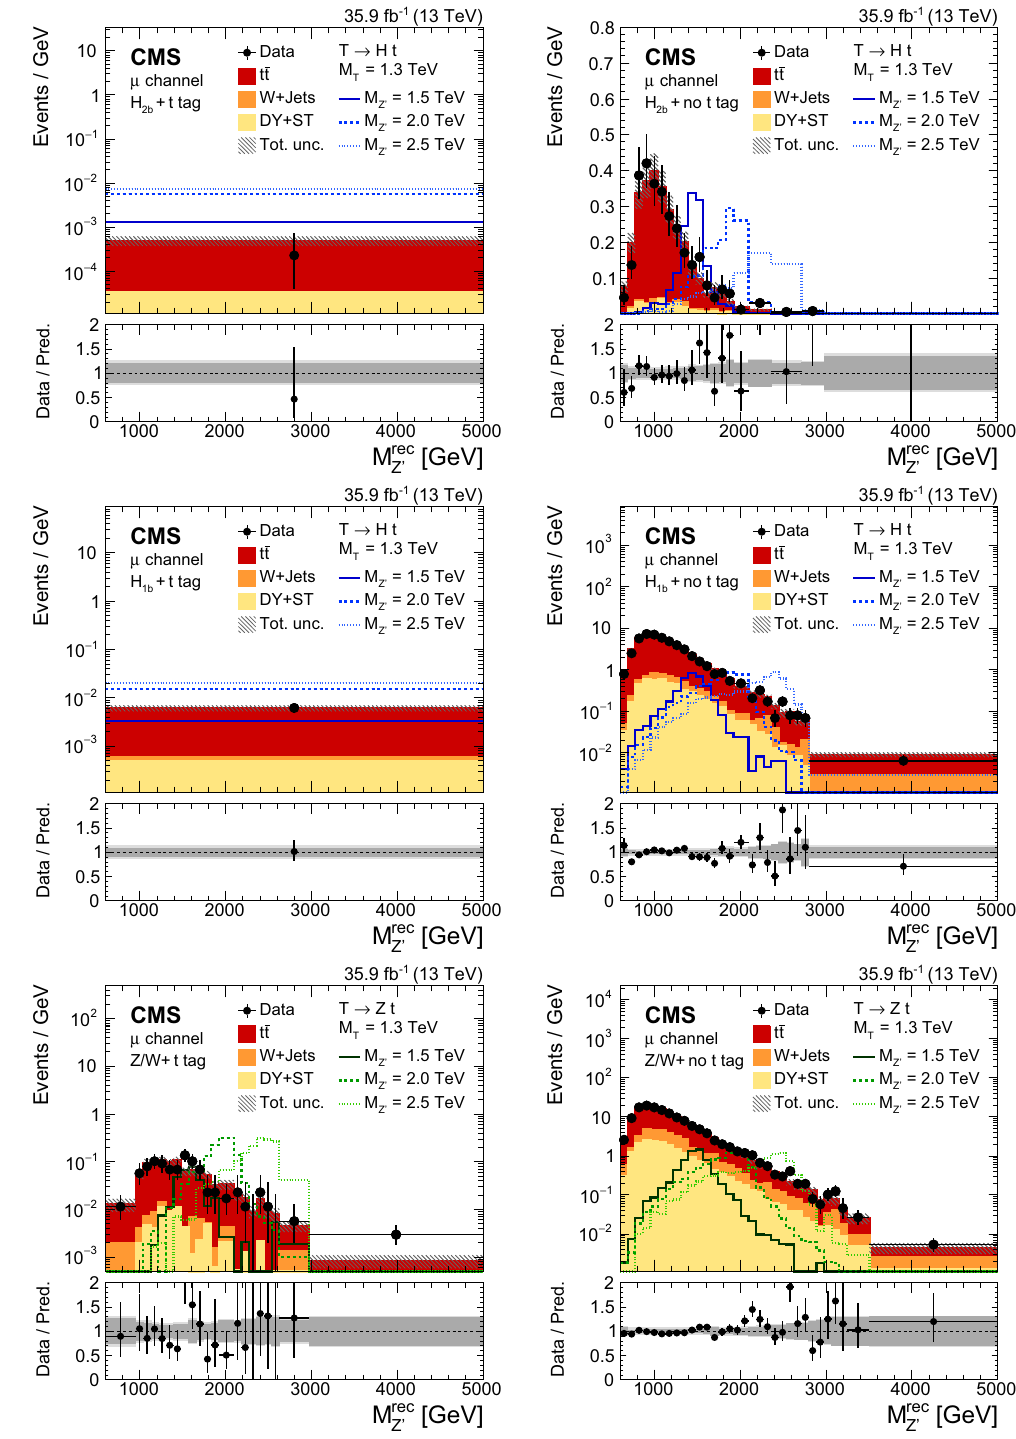
Fig. 5 Distribution of the reconstructed Z (cid:3) resonance mass after the full selection in the μ +jets channel for the data, the expected SM back- ground, and for the signal with different Z (cid:3) masses for a fixed T mass of 1.3TeV. In the left (right) column the results in the top tag (no top tag) category are shown. Different rows display the distributions of events accepted by different taggers as well as the signal for the respective T decays: H 2b tagger and T → Ht decay (upper), H 1b tagger and T → Ht